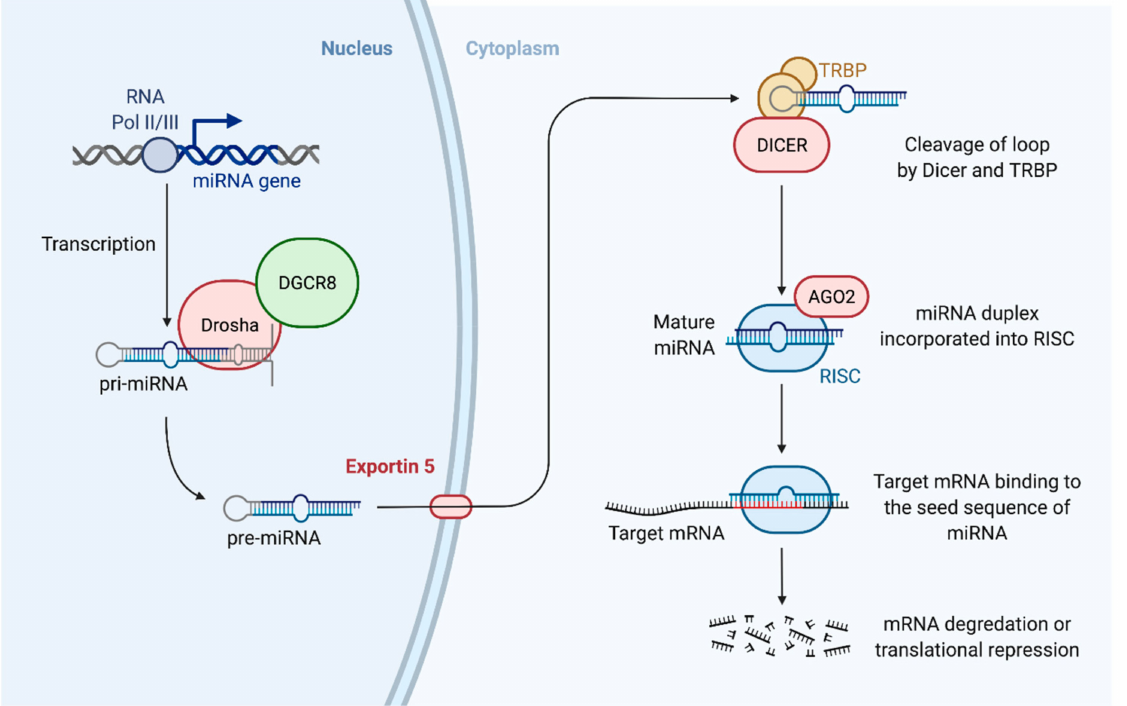
Figure 1. miRNA biogenesis and the mechanism of gene regulation. DGCR8, DiGeorge syndrome critical region 8; TRBP, TAR RNA binding protein; AGO2, Argonaute2; RISC, RNA-induced silencing